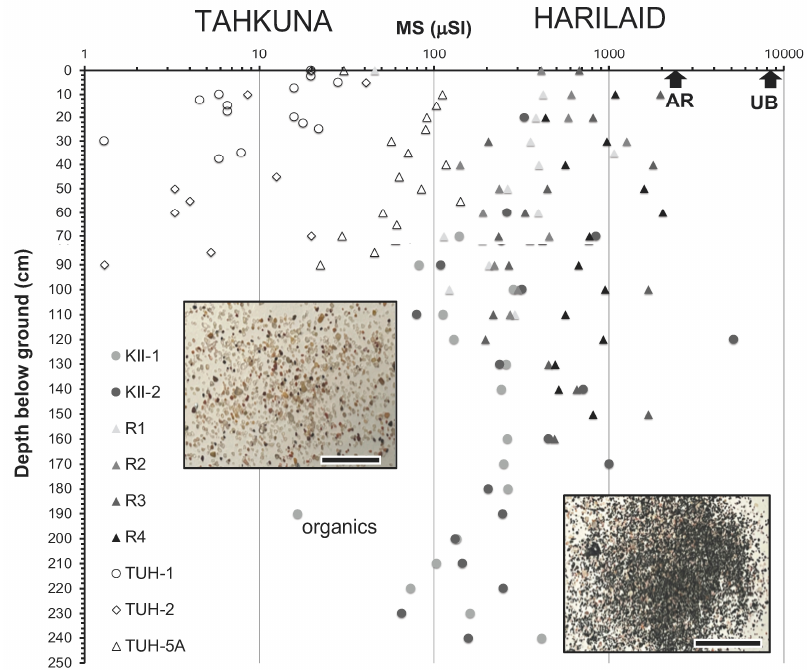
Figure 3. Database of all MS values from the Tahkuna (Hiiumaa) and Harilaid (Saaremaa) sites (logarithmic MS scale). Site names on top reflect the overall pattern as values at Harilaid are 1–2 orders of magnitude greater (mostly >100 µ SI), with a low-value outlier representing an organic sample and the highest (>1000 µ SI) corresponding to modern beach HMCs and specific intervals in trench/core samples (see Figure 4 for selected vertical and lateral stratigraphic trends). Modern upper-berm (UB) and aeolian ramp (AR) HMCs have unusually high MS values (Table 1) due to bedding plane measurements, in contrast to other points. Insets show medium quartz-rich sand and a slightly finer-grained HMC from an active beach at Harilaid (scale bar = 1 cm).